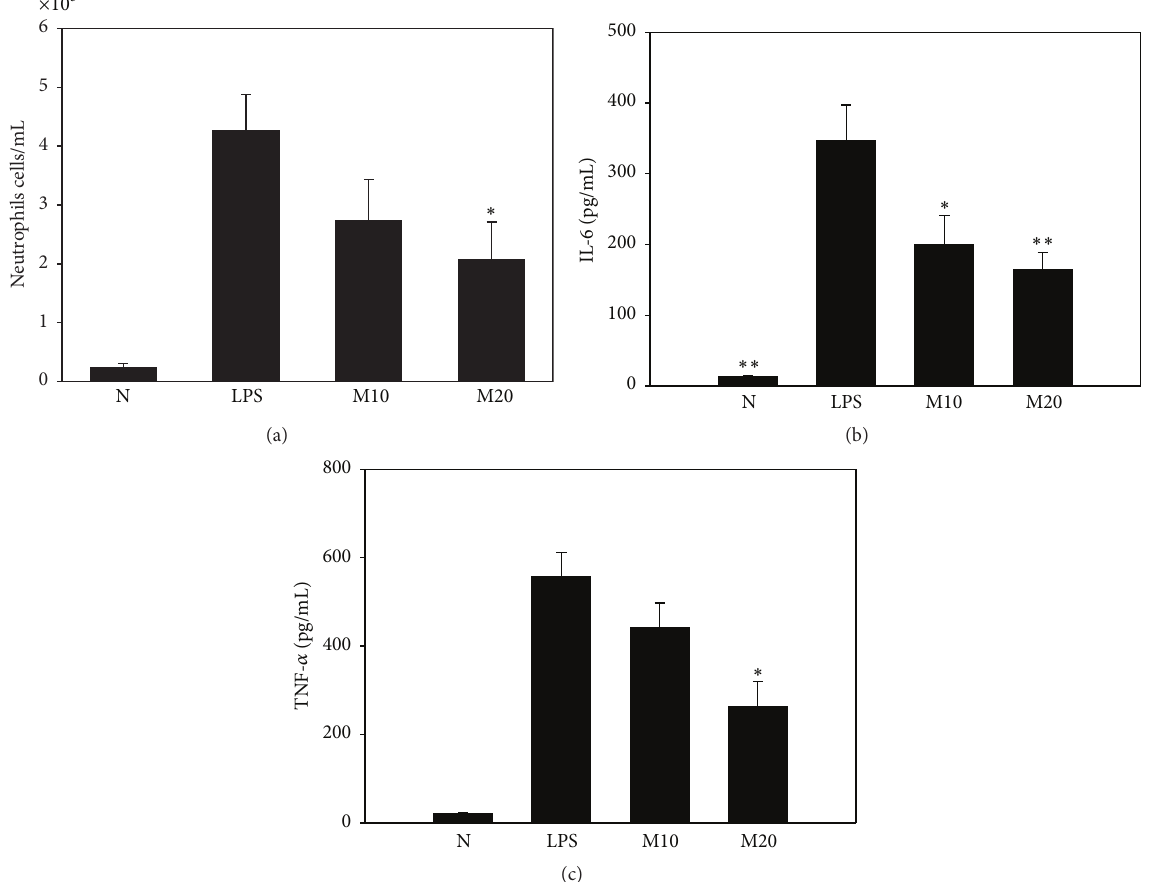
Figure 6: Matrine affects neutrophil counts and cytokine and chemokine levels in BALF. In the different treatment groups, we analyzed neutrophil cell counts (a), and the levels of IL-6 (b) and TNF- 𝛼 (c) were measured by ELISA. N group: normal control mice; LPS group: LPS treatment only; M10 group: 10mg/kg matrine plus LPS; M20 group: 20mg/kg matrine plus LPS. All data are presented as mean ± SEM. ∗ 𝑃 < 0.05 compared with the LPS control group. ∗∗ 𝑃 < 0.01 compared with the LPS control